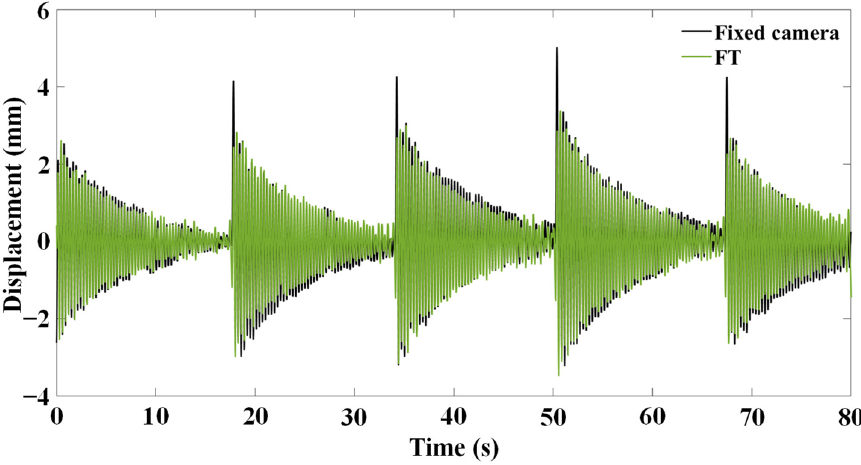
Figure 10. Displacement signal measured by the fixed camera and corrected signal by FT ( F = 2 Hz).